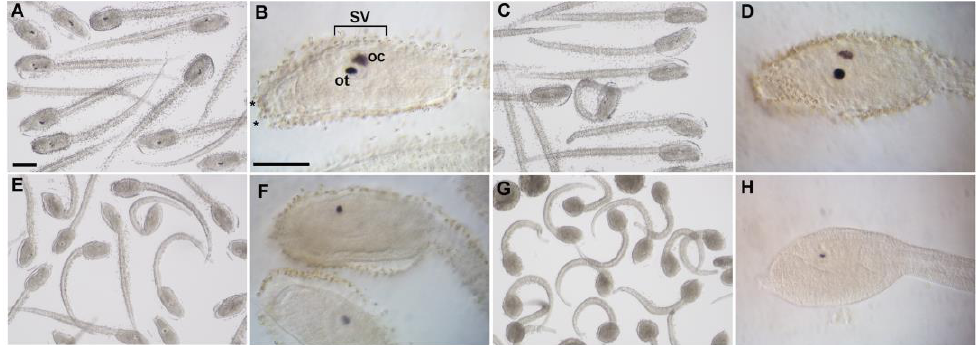
Figure 3. Effects of WAY-100635 treatment on larval morphology. Control samples ( A , B ) and larvae exposed to 10 µM ( C , D ), 25 µM ( E , F ), and 50 µM ( G , H ) WAY-100635. General morphology and magnification of larval trunk are displayed. Scale bars: 100 µm ( A ) and 50 µm ( B ). Abbreviations: SV= sensory vesicle; ot = otolith; oc = ocellus; * = palps.